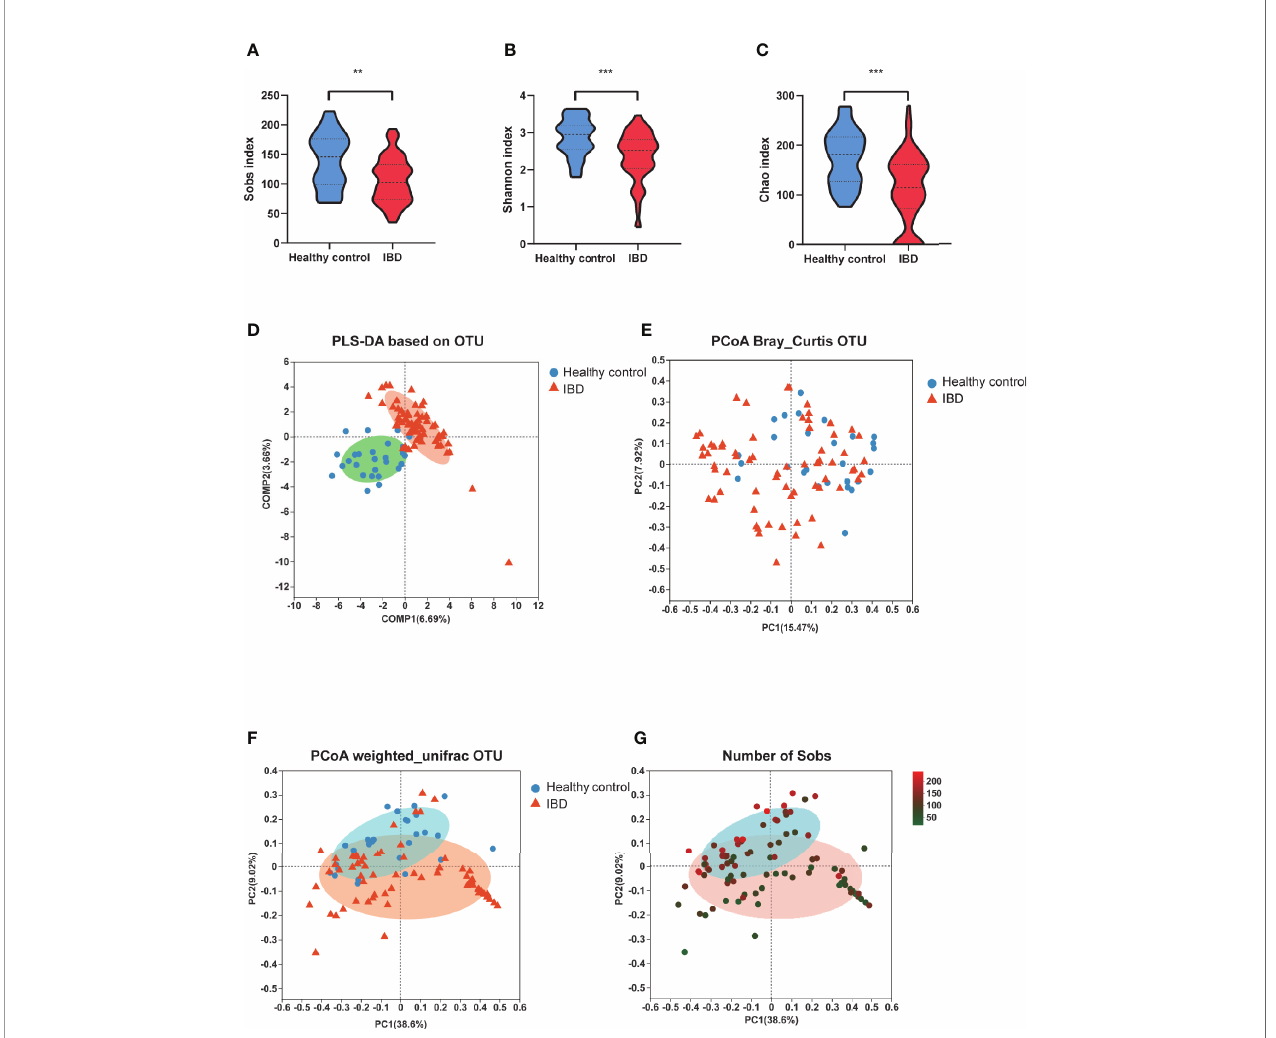
FIGURE 1 | Changes of fecal microbial diversities: IBD (n=66) compared with healthy controls (n=27). a -Diversity illustrated by microbiota richness number of observed operational taxonomic unit (OTU) and evenness Sobs index (A) , Shannon index (B) and Chao (C) were reduced in IBD (**p<0.01, ***p<0.001). (D) showed the PLS-DA based on OTU compositions. (E) PCoA demonstrated under Bray Curtis distance (F model: 3.78, P<0.001) (F) PCoA demonstrated under weighted unifric that individuals with IBD were different from healthy controls. (G) The same PCoA plot as F colored by a -diversity measured by the number of Sobs